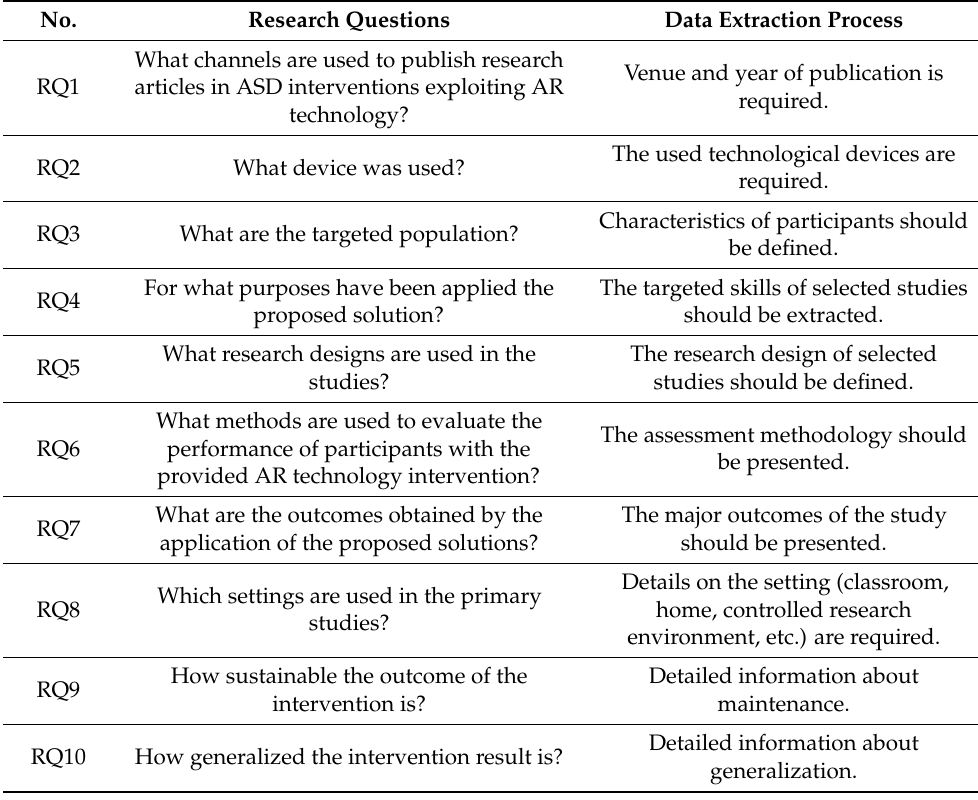
Table 1. Research